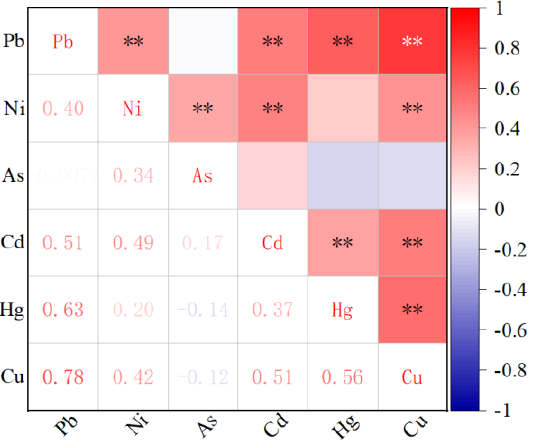
Figure 6. Correlation heat map of heavy metals. ** represents the significance level of p-value < 0.05.